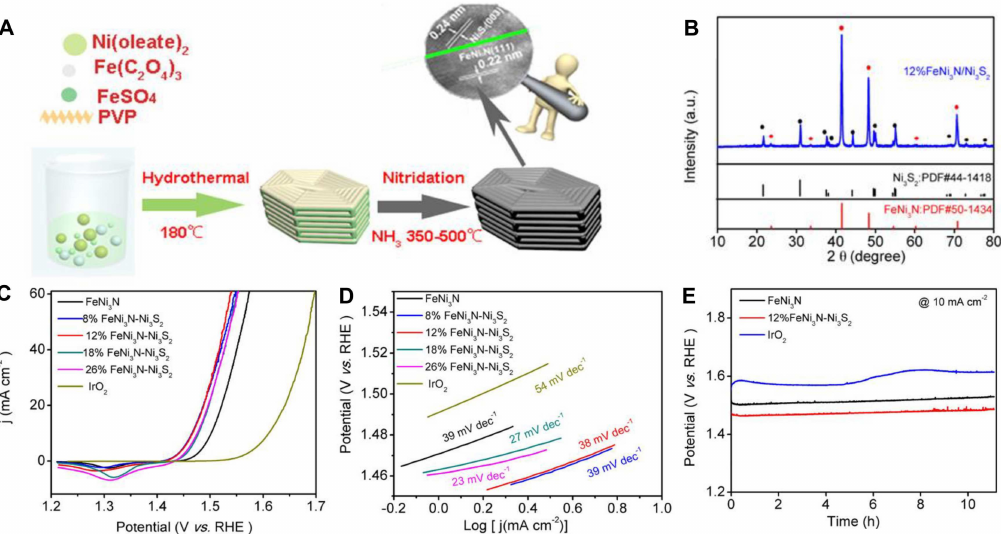
Figure 7. ( A ) Schematic illustration of the formation of FeNi 3 N-Ni 3 S 2 samples; ( B ) XRD pattern of FeNi 3 N-Ni 3 S 2 ; ( C ) LSV curves of different electrocatalysts in 0.1 M KOH electrolyte; ( D ) Tafel plots of different electrocatalysts; ( E ) potential cycling performance of FeNi 3 N-Ni 3 S 2 , FeNi 3 N, and IrO 2 . Reproduced with permission from [91]. Copyright © 2020 American Chemical